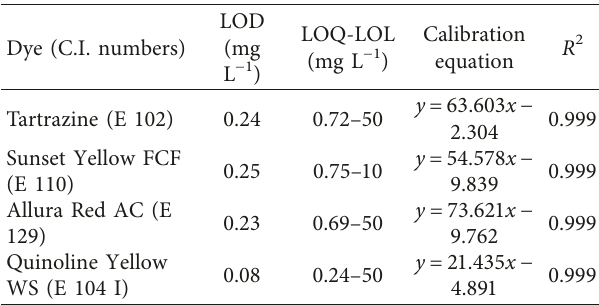
Table 4: Limits of detection (LOD), dynamic range (LOQ-LOL), calibration equations, and coefficients of determination ( R 2 ) of